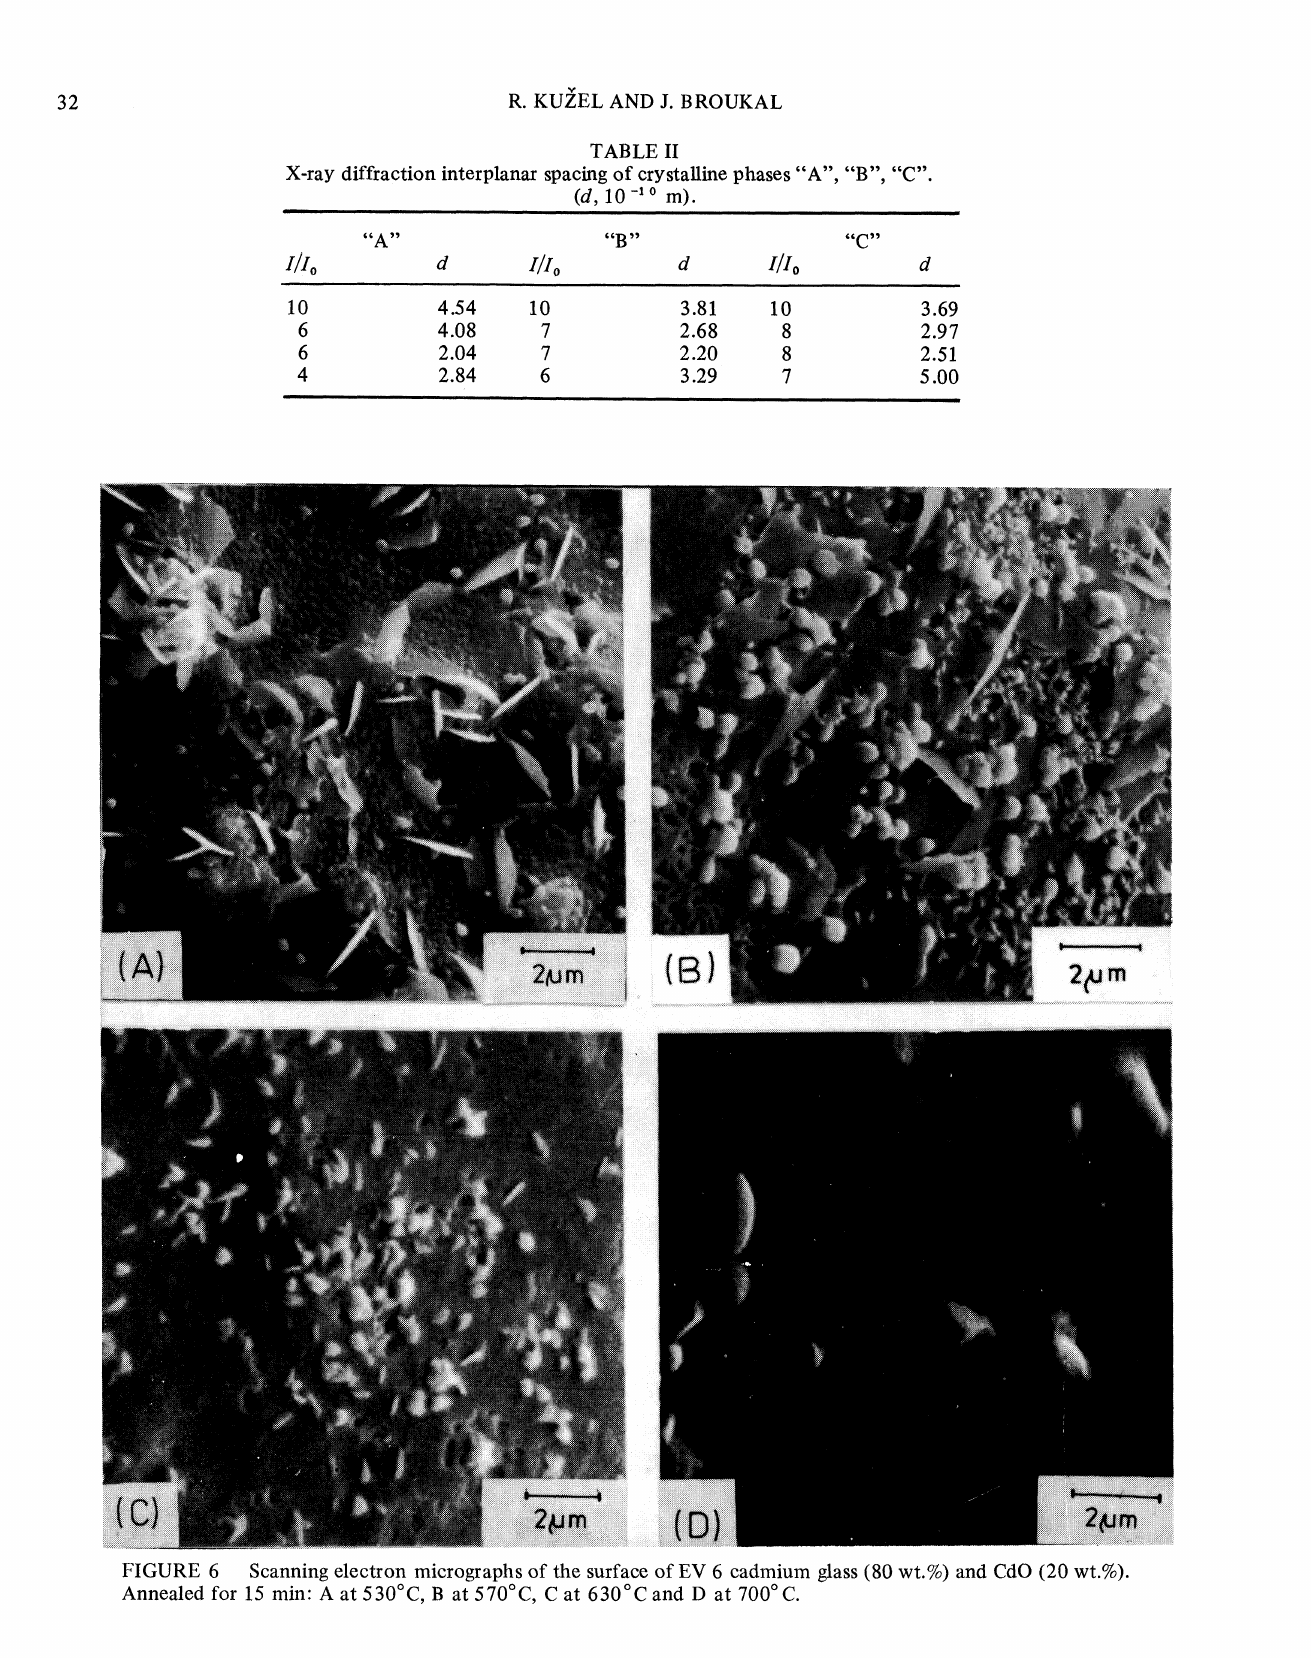
TAB LE II X-ray diffraction interplanar spacing of crystalline phases "A", "B", "C".